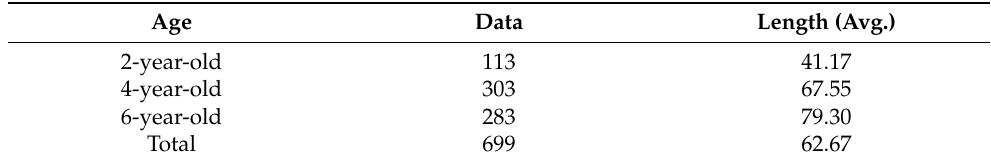
Table 5. Description of data used in